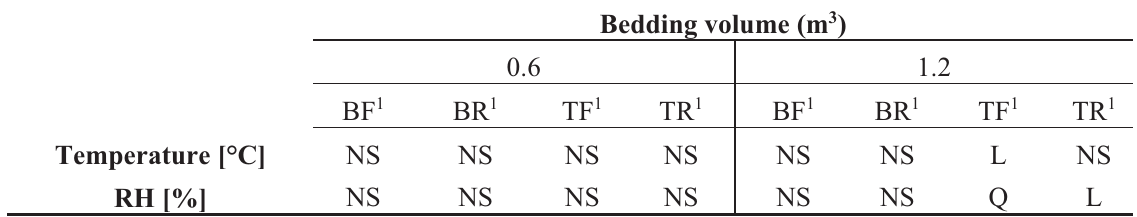
1 BF = bottom front, BR = bottom rear, TF = top front, TR = top rear compartments. Note: Significant Temperature and relative humidity over time (either linear or quadratic) have been plotted in Figure 9.